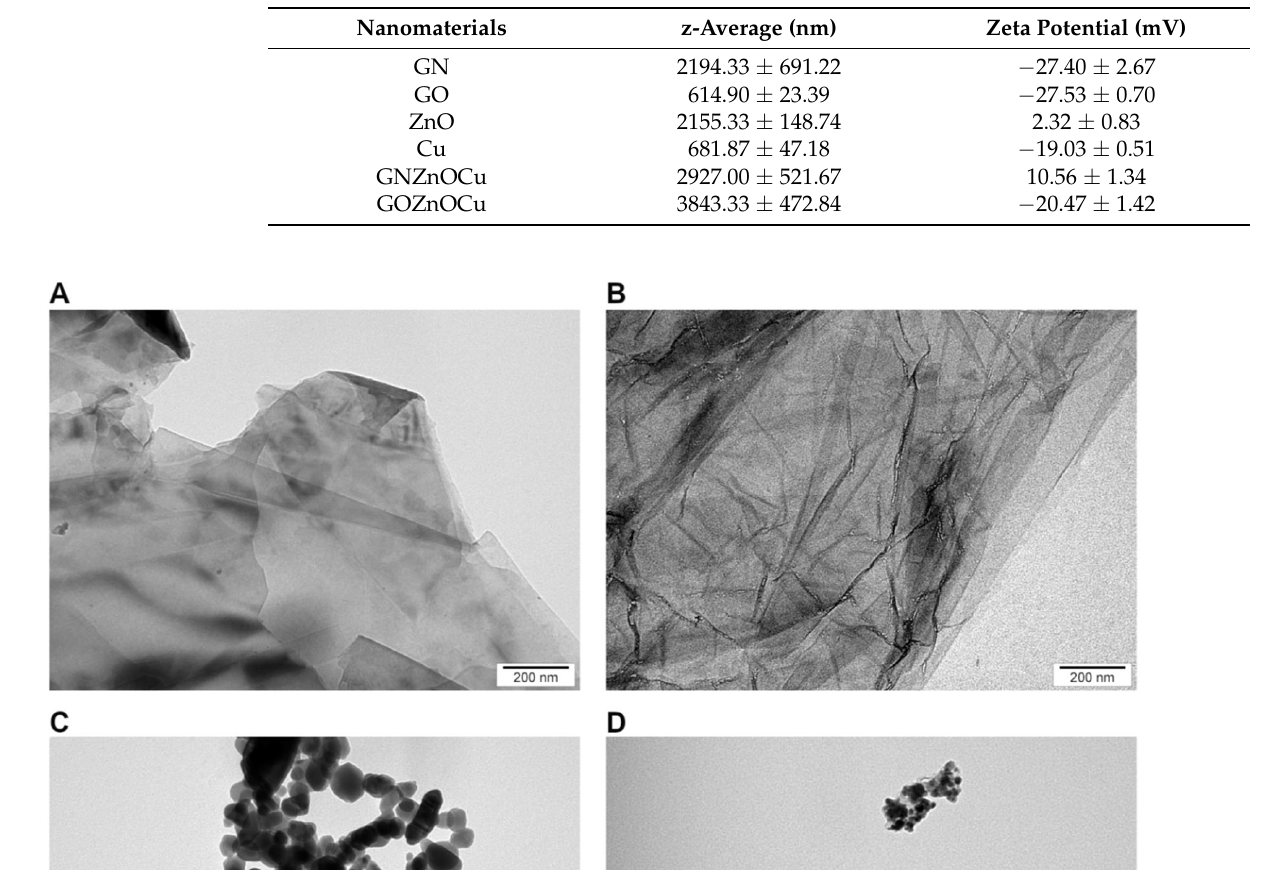
Table 1. Mean diameter (nm) and zeta potential (mV) of nanoparticles aggregates and nanocomposites tested.